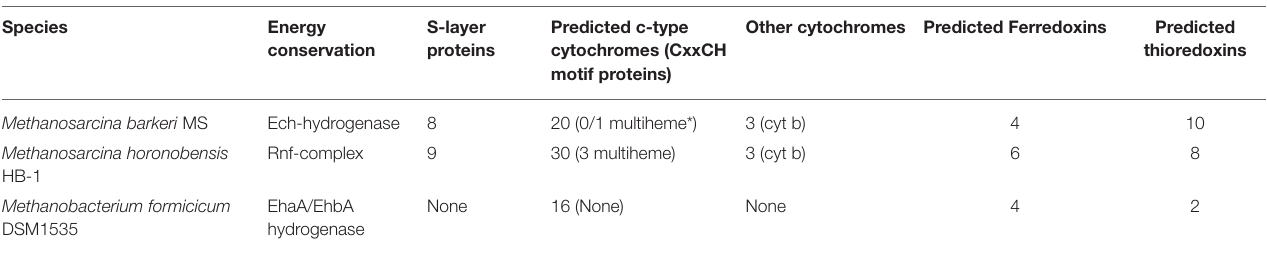
TABLE 1 | Relevant genotypic differences between the methanogens tested during this study.